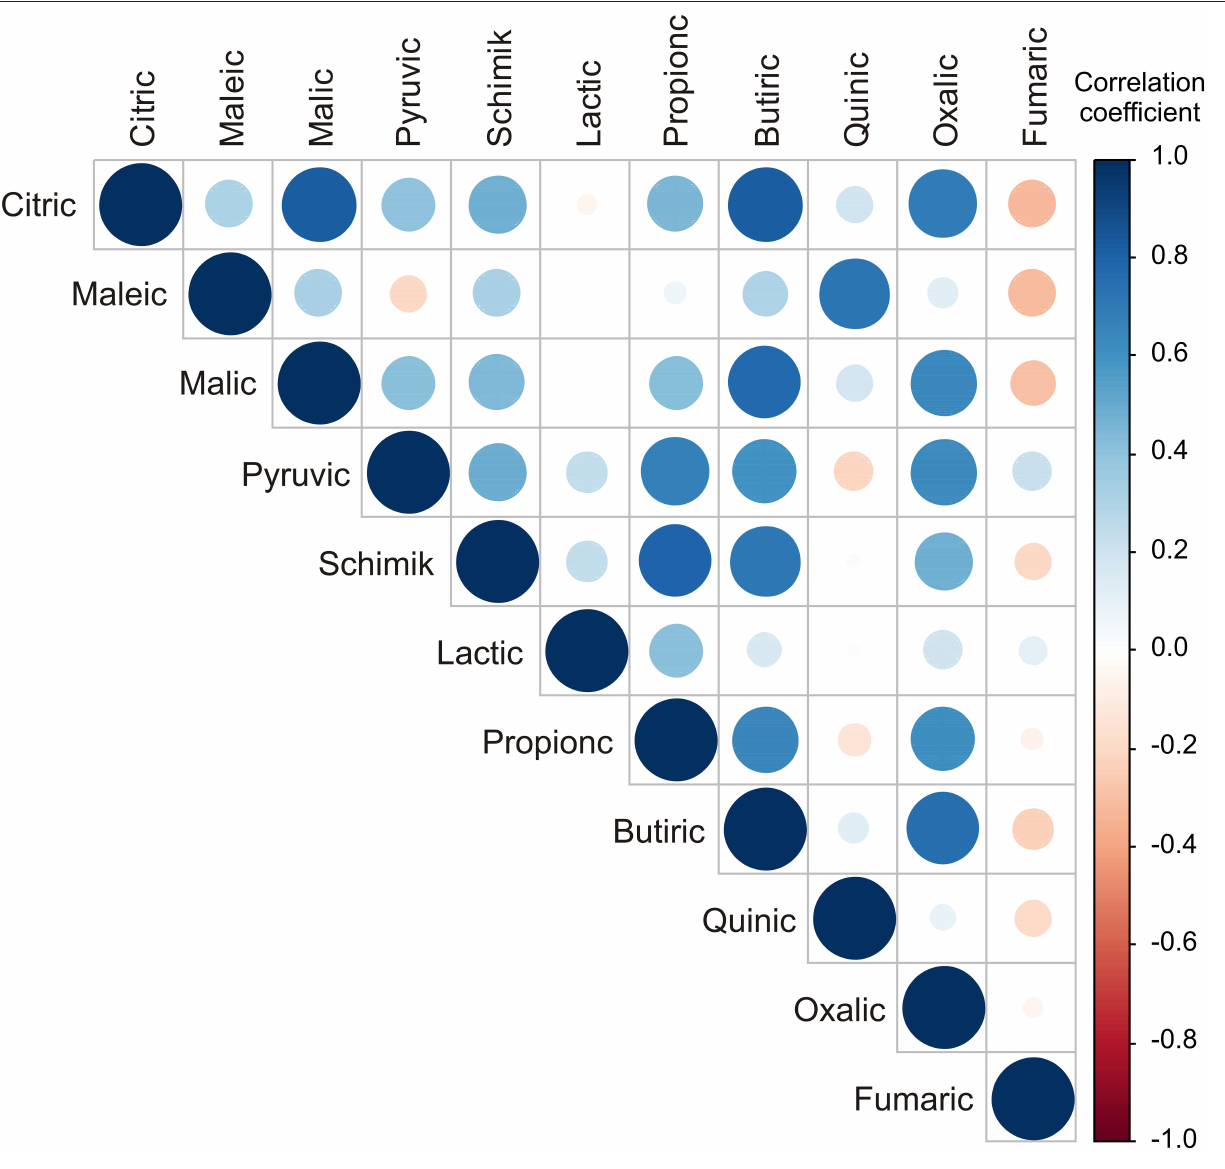
FIGURE 3 | Color correlation graph between fruit acids content in apple